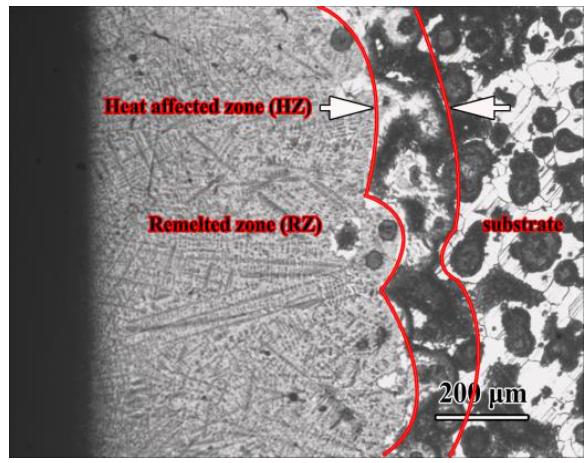
Figure 4. The microstructure of ductile iron gradient remelted by the plasma transferred arc includes remelted zone (RZ), heat-affected zone (HZ), and substrate.